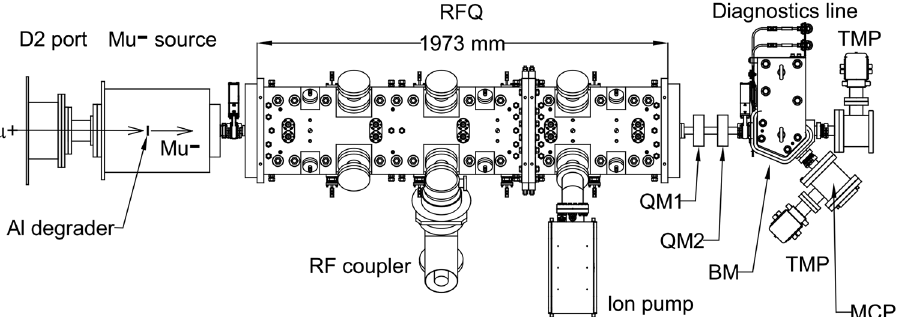
FIG. 1. Schematic drawing of the experimental